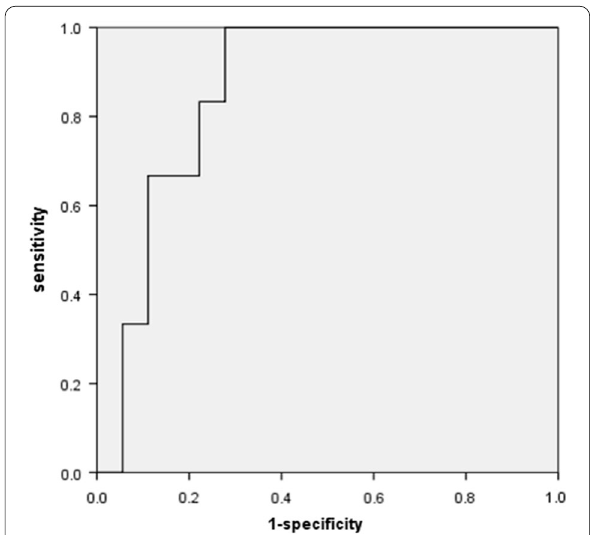
Fig. 4 The ROC curves of the FVF in predicting lymphovascular invasion. The AUC was 0.861 at the cut-off value of 37.8%, with a sensitivity of 100% and specificity of